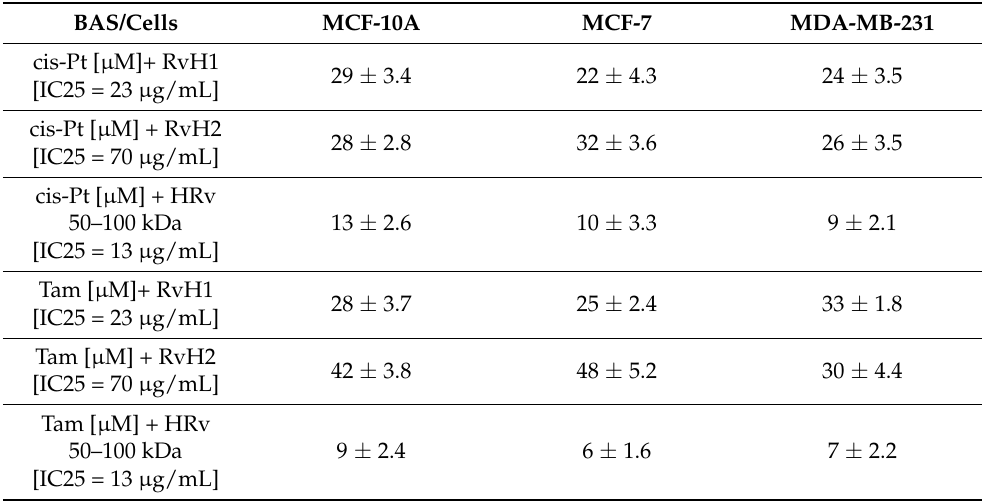
Table 3. IC 25 of BAS, isolated from R. venosa , in combinations with cisplatin or tamoxifen in serial dilutions from 16 to 512 µ M tested on breast cancer cell lines MCF-7 and MDA-MB-231 and the non-cancerous MCF-10A breast cell